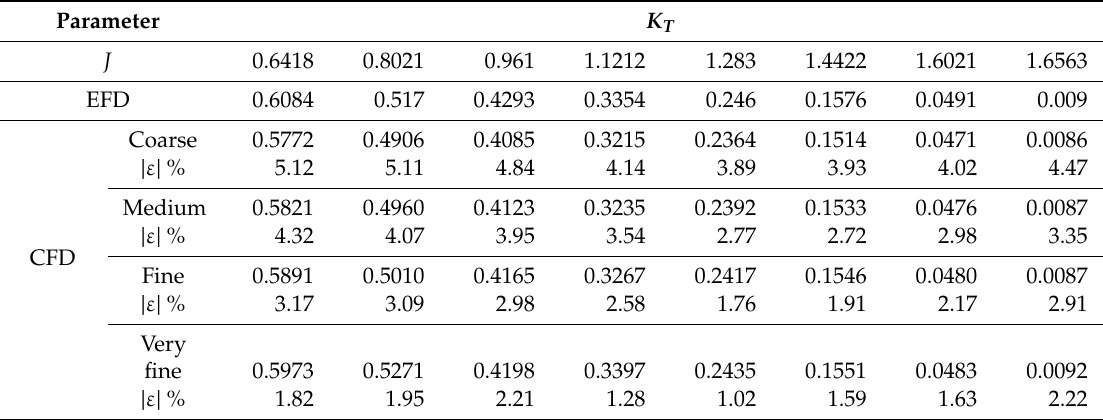
Table 3. Grid convergence test for the thrust coe ffi cient. Wetted propeller case.